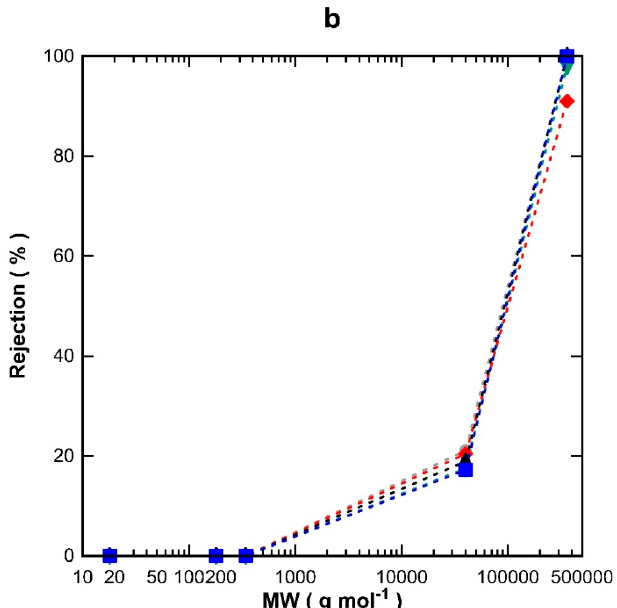
Figure 4. Single layer TM membranes at different vacuum times ( a ) flux and ( b ) percentage of rejection as a function of molecular weight (MW) for TM0 (grey circles), TM30 (green inverted triangles), TM120 (red diamonds), TM600 (black triangles) and TM1200 (blue squares).